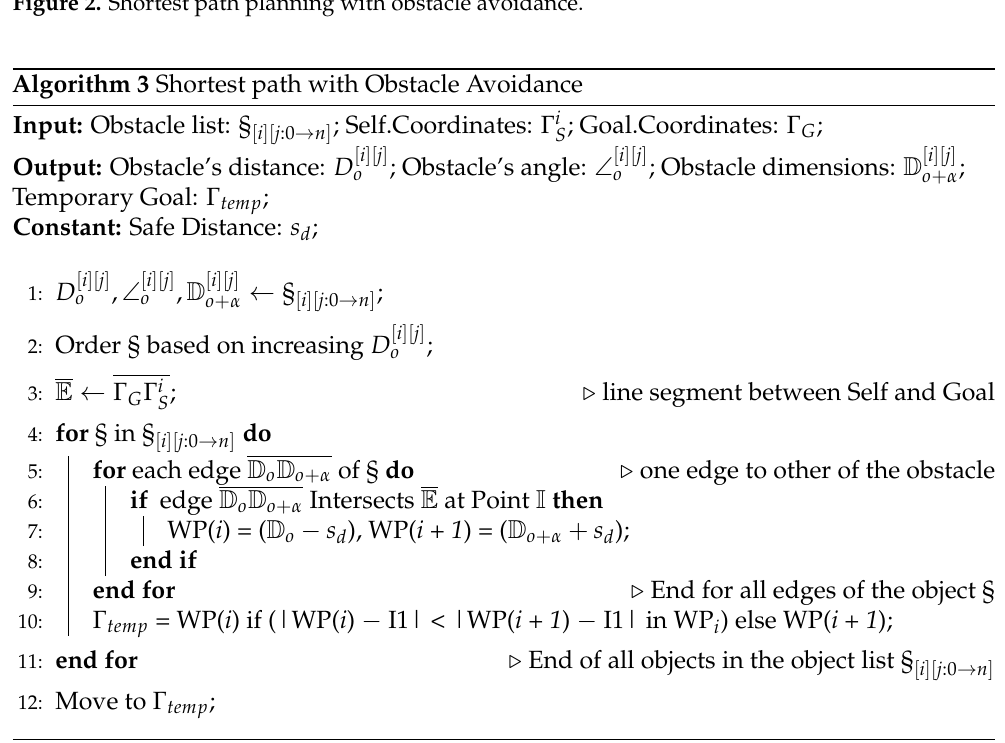
Figure 2. Shortest path planning with obstacle avoidance.